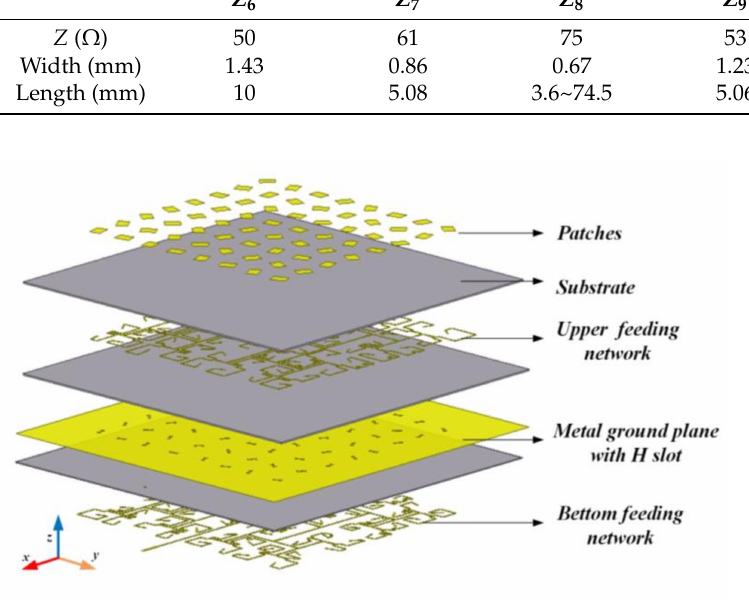
Figure 7. 3-D view of the planar microstrip quad-vortex patch array in Case